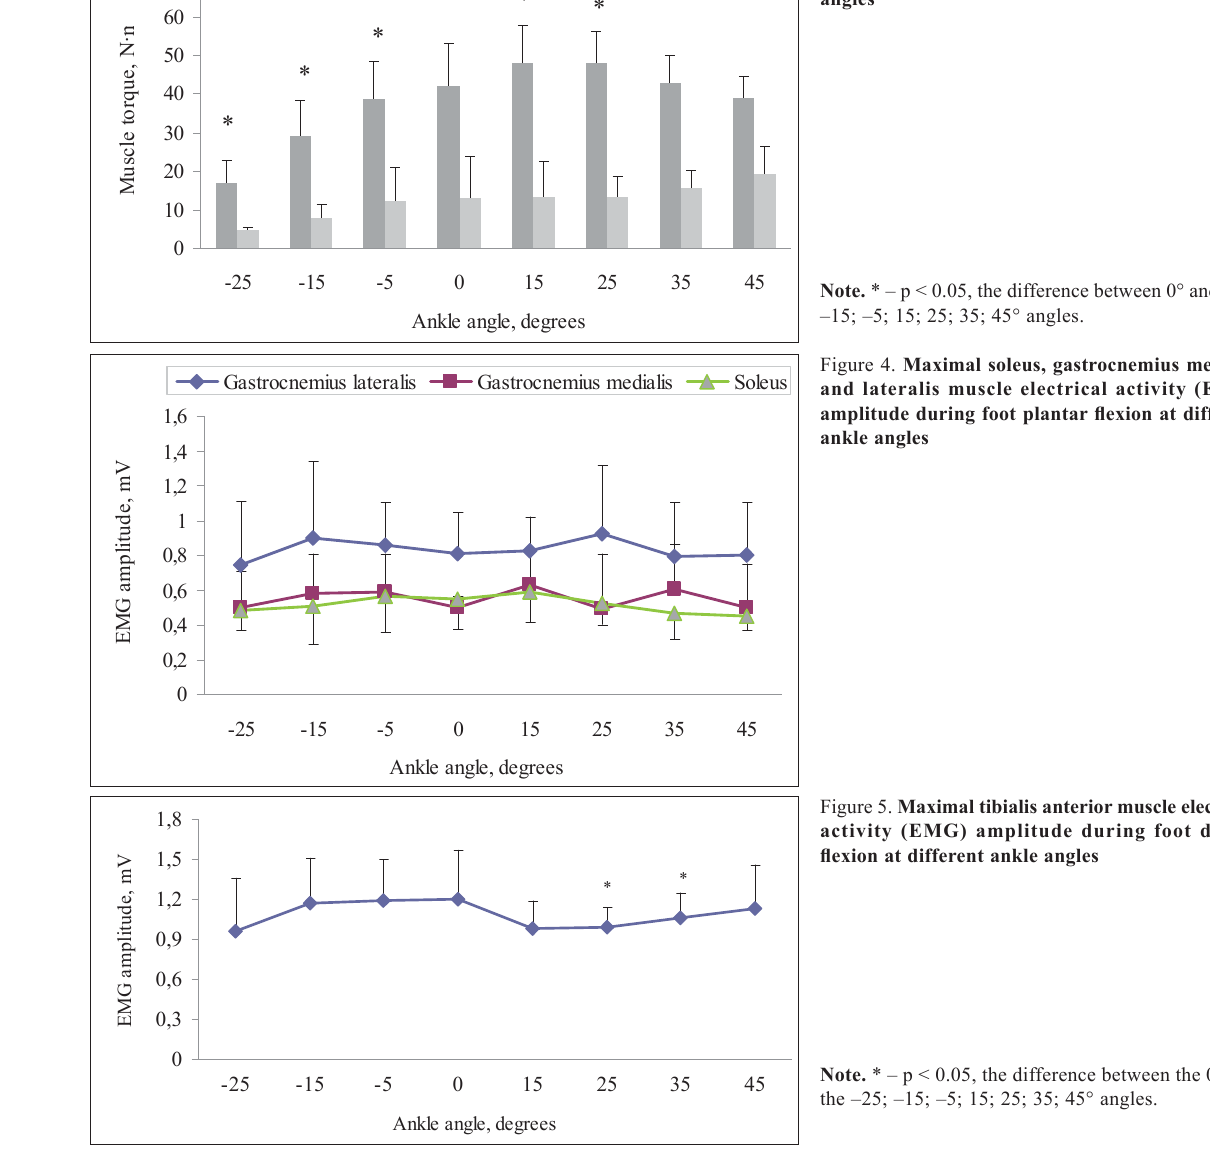
Figure 3. Maximal voluntary contraction (MVC) and electrical stimulation (ES) – evoked muscle torques during ankle dorsal flexion at different angles